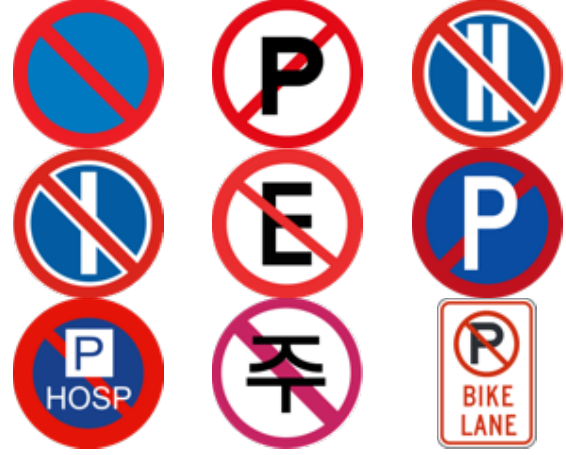
Figure 10. Country specific “No parking” signs currently managed by the Mapillary algorithm